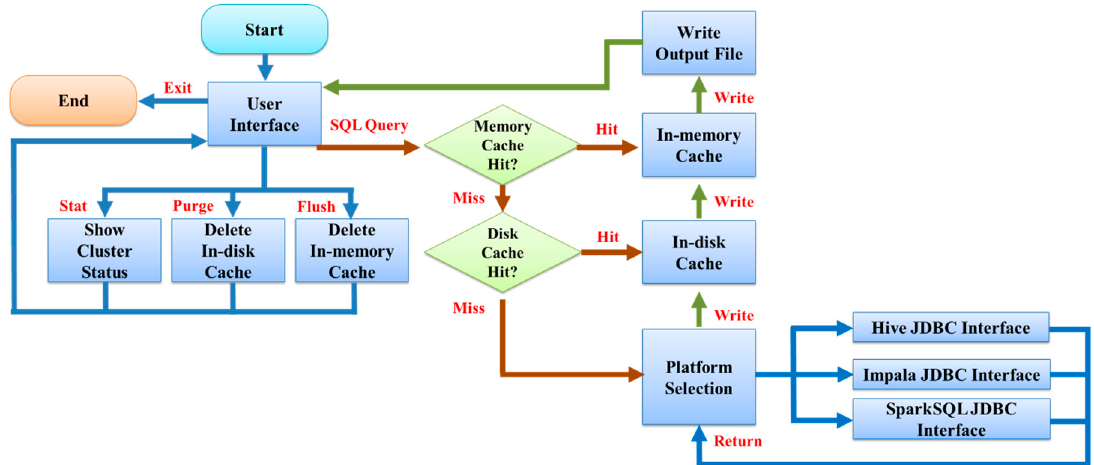
Figure 12. Flowchart of input queries proceeded in multiple big data tools.